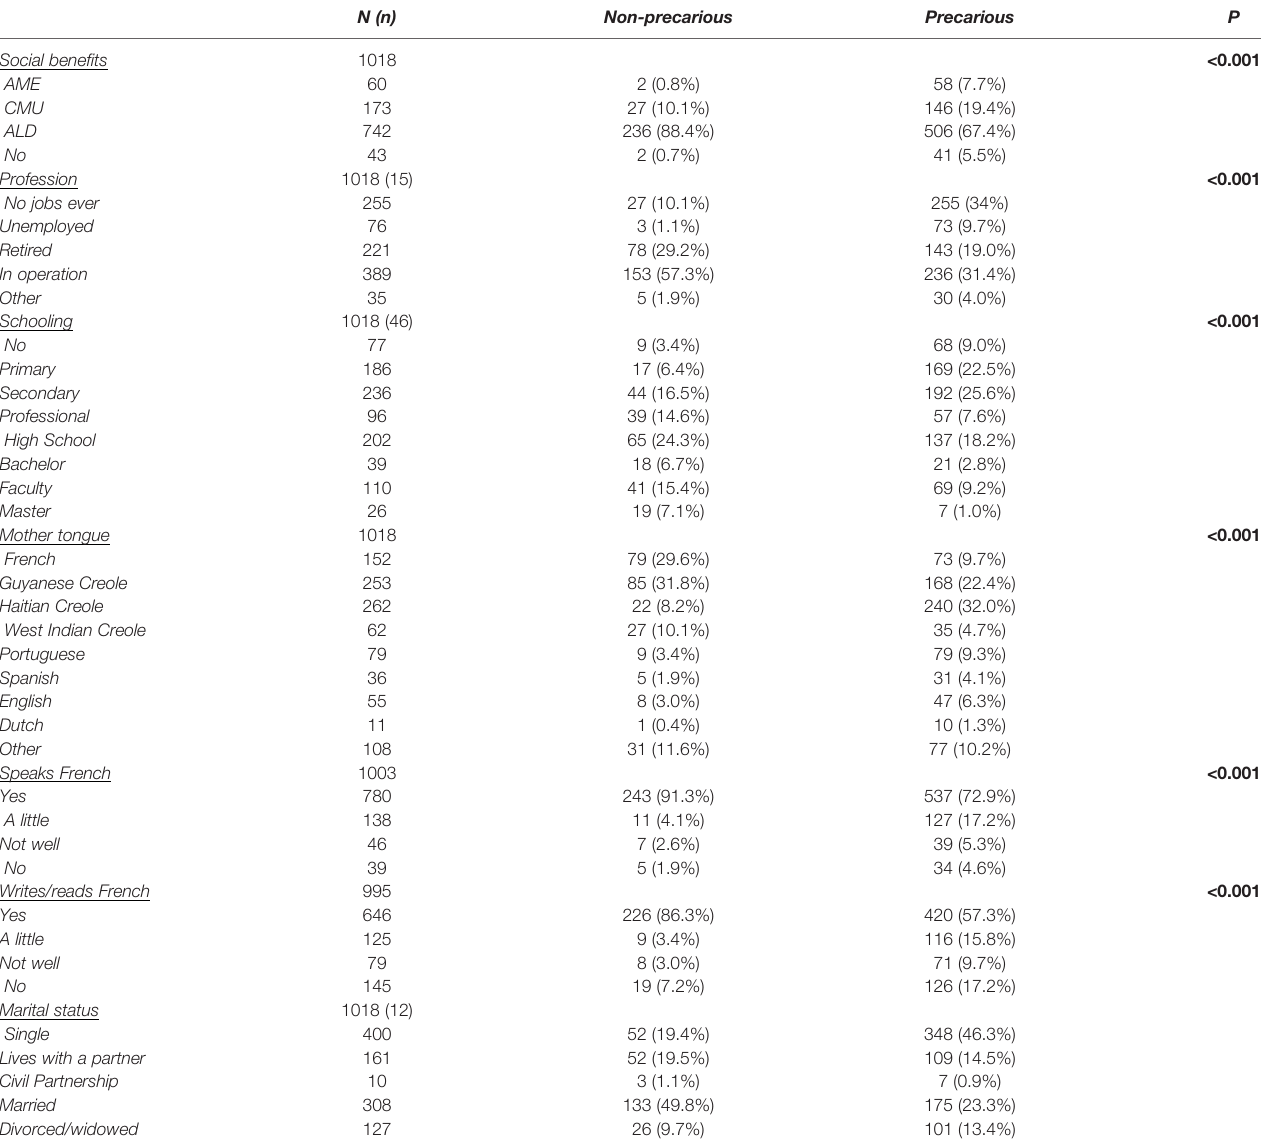
TABLE 1 | Sociodemographic characteristics of the study population according to Precariousness. N